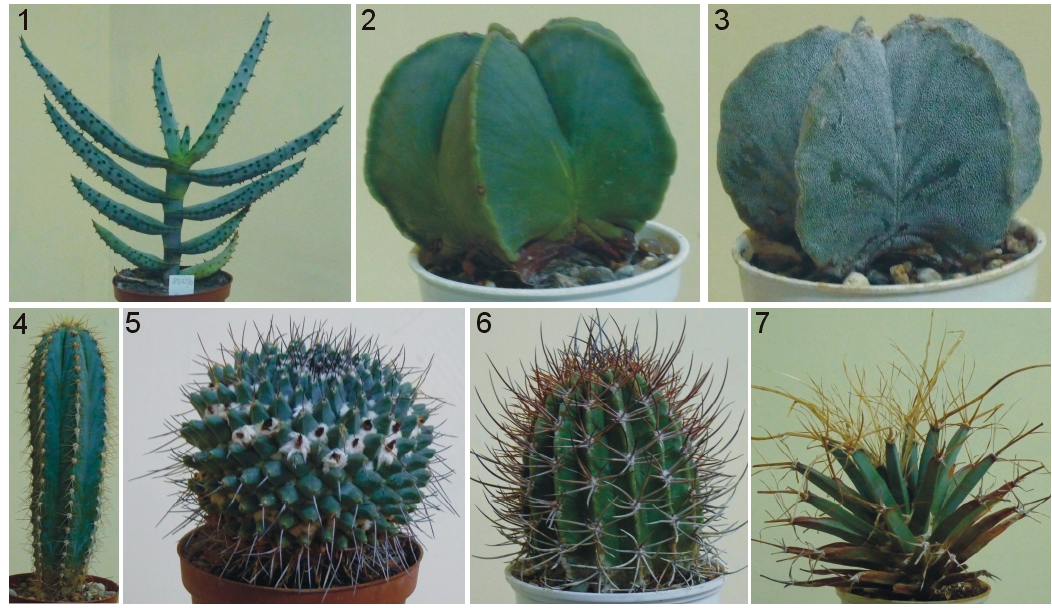
Figure 11. Scanned plant species which had computer models created. 1. Aloe marlothii; 2. Astrophytum capricorne; 3. Astrophytum myriostigma; 4. Pilosocereus pachycladus; 5. Mammillaria magnimamma; 6. Echinopsis leucantha; 7. Leuchtenbergia principis.